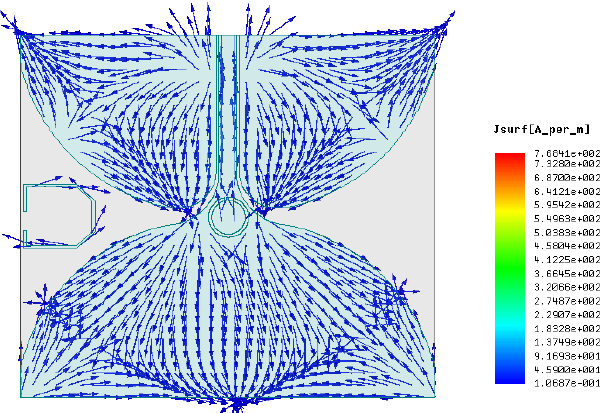
Figure 8: Surface current distribution at f=5.5GHz of the dual band-notch proposed